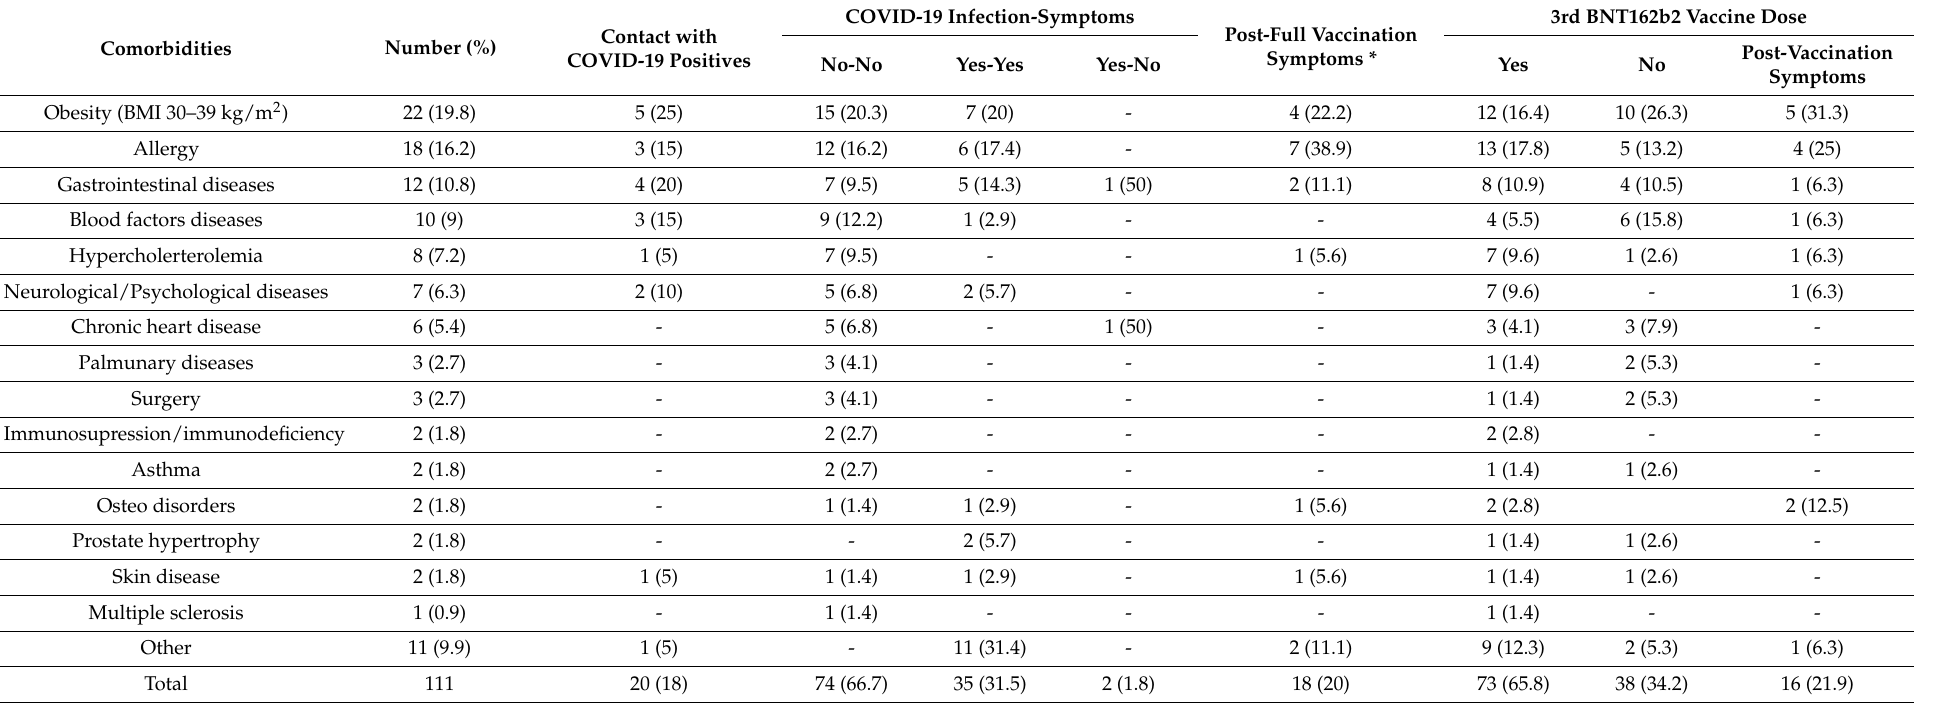
Table 4. Evaluation of the vaccination status and the history of SARS-CoV-2 infection in participants with comorbidities [quantitative data are presented as number